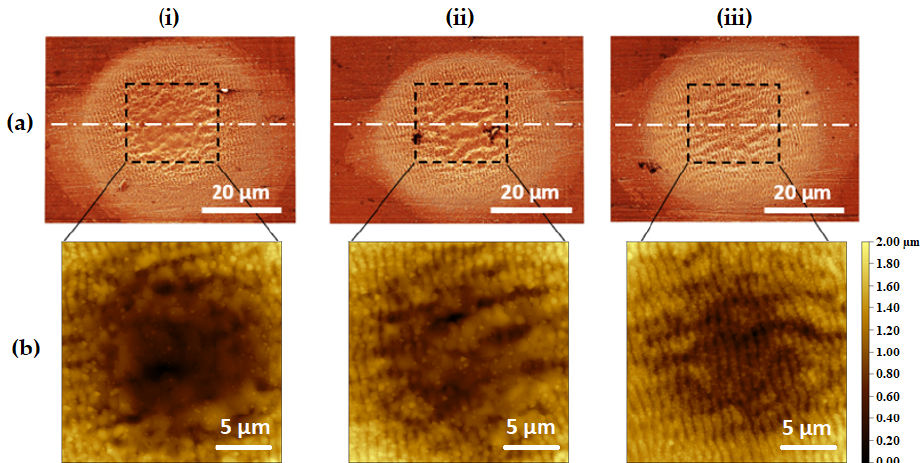
Figure 9. ( a ) SEM pictures (false color) of the static shots performed on stainless steel with a scale bar of 20 µm, ( b ) AFM characterization of the 20 × 20 µm central zone for each impact of ( a ) with a scale bar of 5 µm: ( i ) increasing gradient with 20 pulses distributed in the range 0.5–9.5 J/cm 2 , ( ii ) uniform energy with 20 pulses at 5 J/cm 2 , ( iii ) decreasing gradient with 20 pulses distributed in the range 9.5–0.5 J/cm 2 .